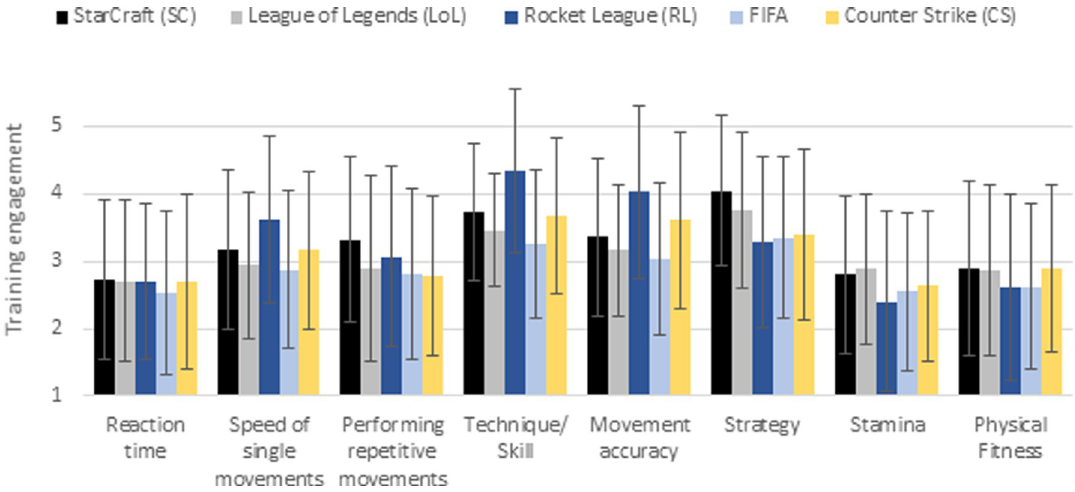
Fig 14. Engagement in training fields. Scale: 1 –never; 3 –occasionally; 5 –very often.